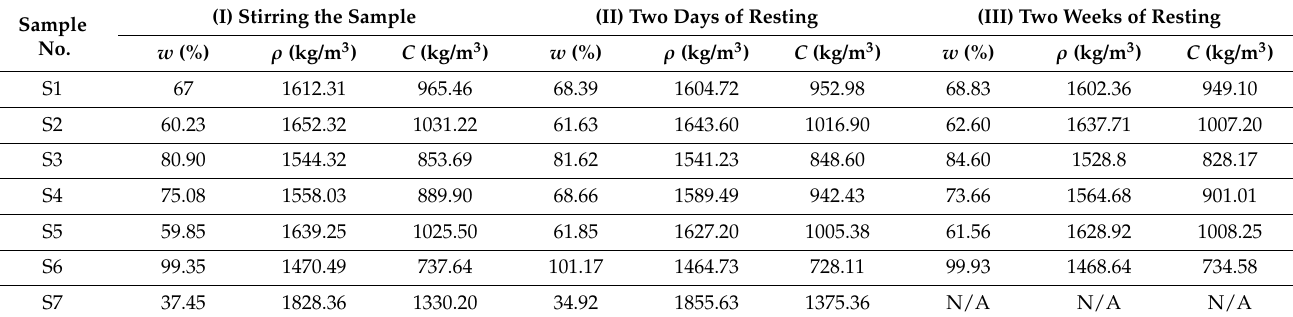
Figure 6. Oscillatory amplitude sweep test results for Sample S5-I. Table 4. Water content, density, and sediment concentration in sediment samples for three steps.